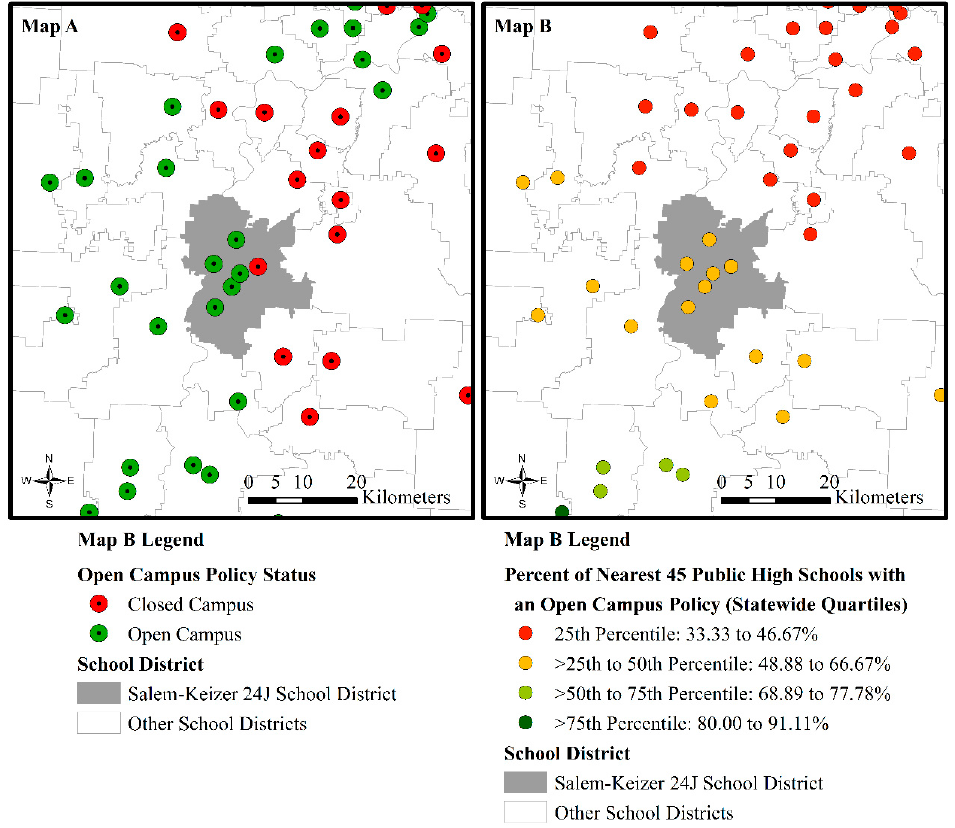
Figure 4. ( A ) Open campus policy status of Oregon public high schools and ( B ) the percent of nearest 45 public high schools in relation to the example case of the Salem–Keizer 24J School District and neighboring school districts.